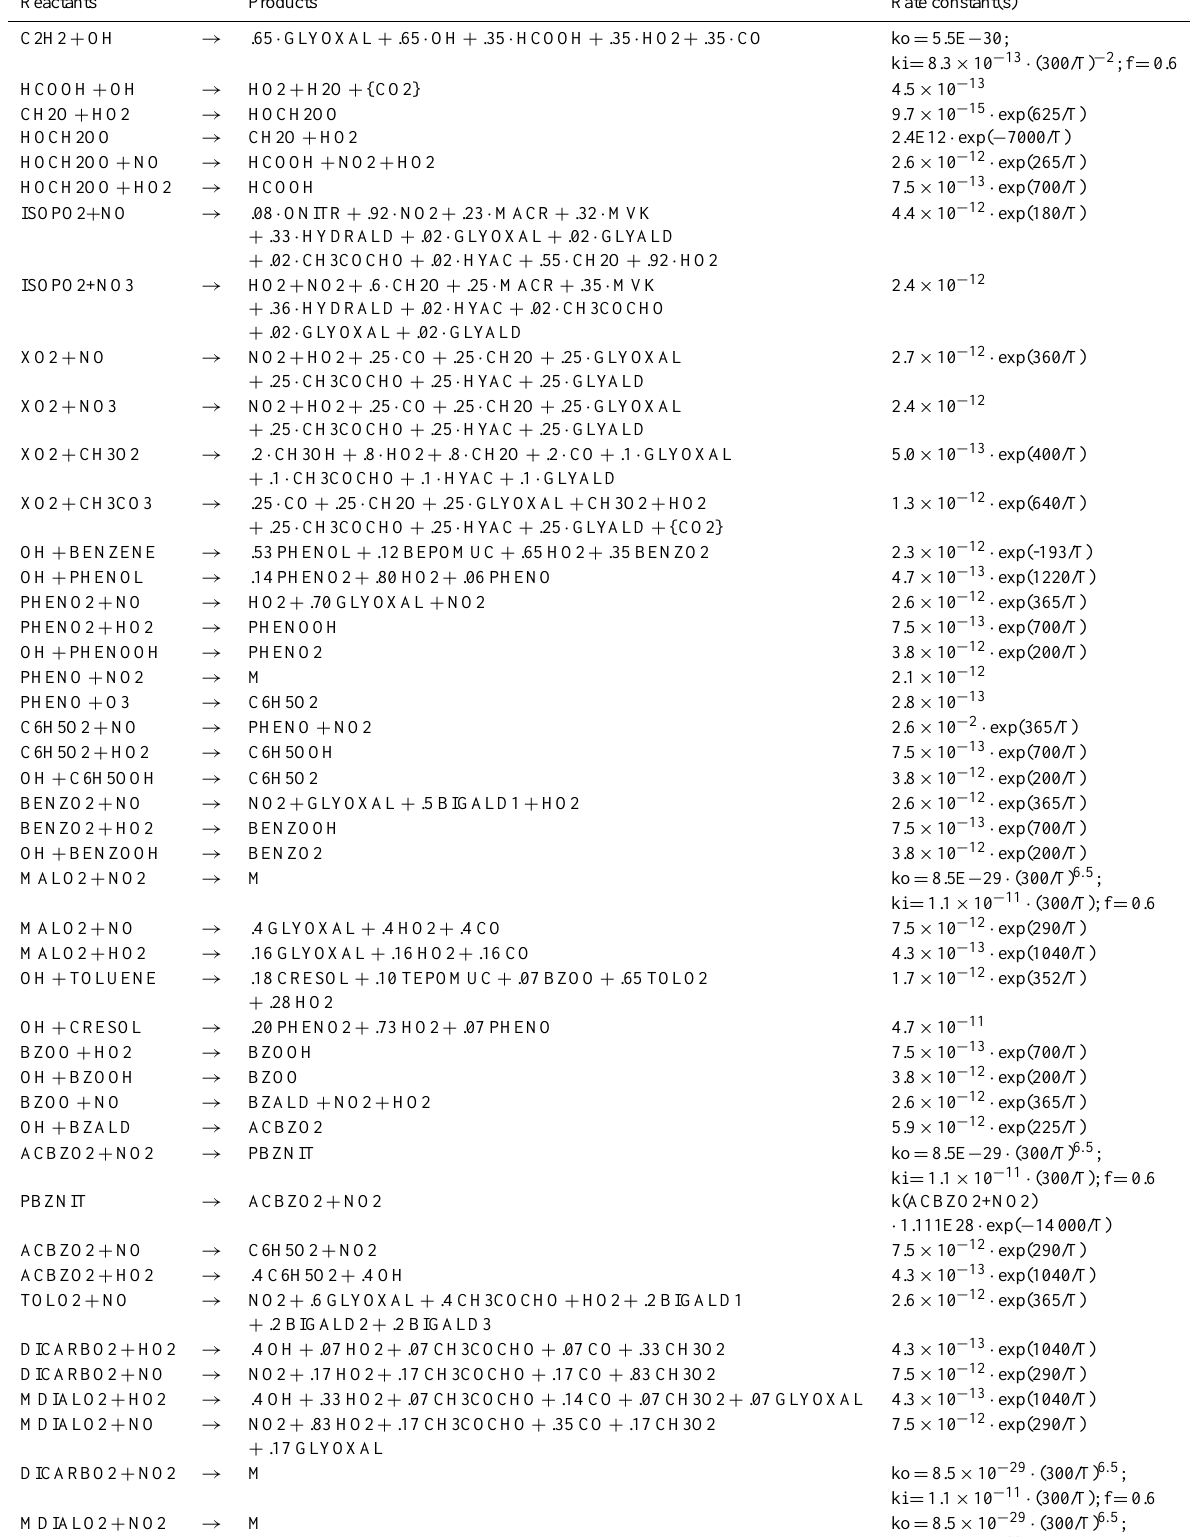
Table 4. New/updated gas-phase reactions. ({CO2} indicates CO 2 is not included in the model solution.) Reactants